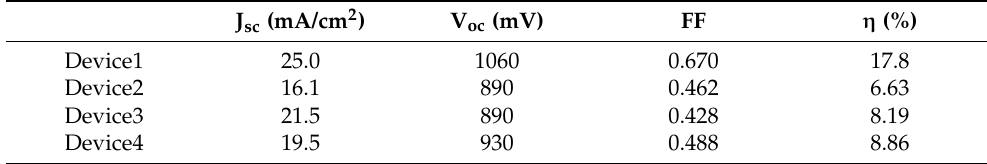
Figure 7. ( a , b ) TEM images of the as-deposited film after nanofluid pool boiling. The yellow part shown in ( a ) corresponds to the position of the high-resolution TEM (HR-TEM) image of ( b ). ( c ) The selected-area diffraction pattern indicating the diffraction spots of the 101 plane of the TiO 2 particles that correspond to the image ( b ). ( d ) HR-TEM image of the sintered sample at 550 °C (ramping rate: 15 °C/min, period of maximum temperature: 1 h). The area shown in a dotted yellow line indicates the joining of some TiO 2 nanoparticles as a result of the sintering process. The spacing of each lattice fringe, 0.35 nm, of the TiO 2 anatase phase is omitted for clarity. Table 1. Photovoltaic performance of the perovskite solar cells under a simulated solar light. The best-performing data from the reverse scan were summarized for each